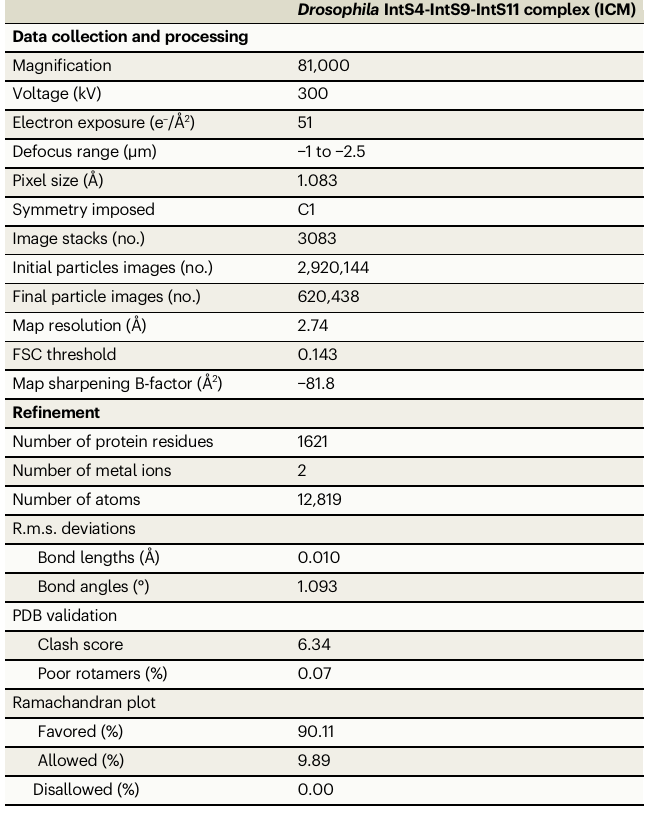
Table 1 | Cryo-EM data collection, structure re fi nement, and validation